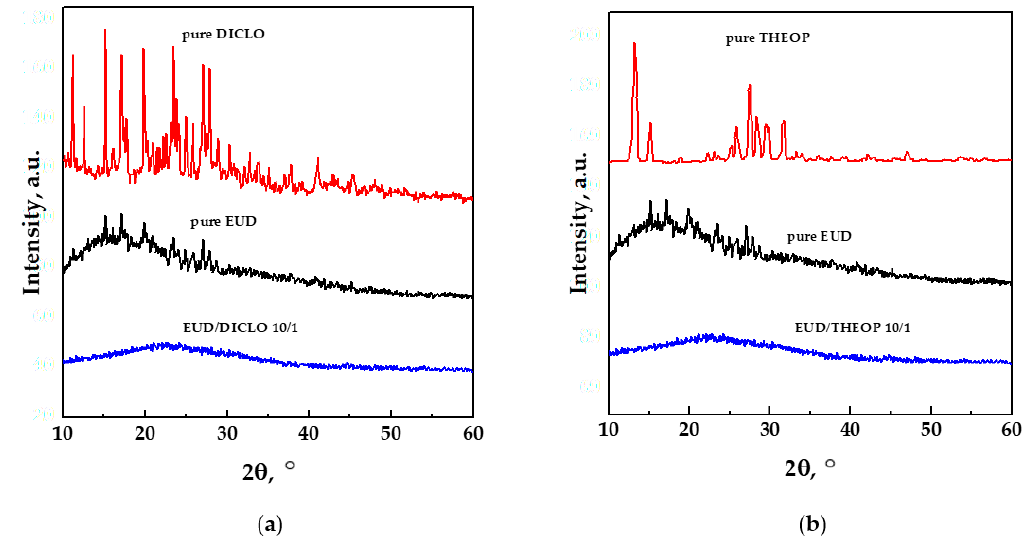
Figure 13. XRD patterns of unprocessed EUD, unprocessed drugs, and SAS processed EUD/drug coprecipitated powders. ( a ) DICLO; ( b ) THEOP.